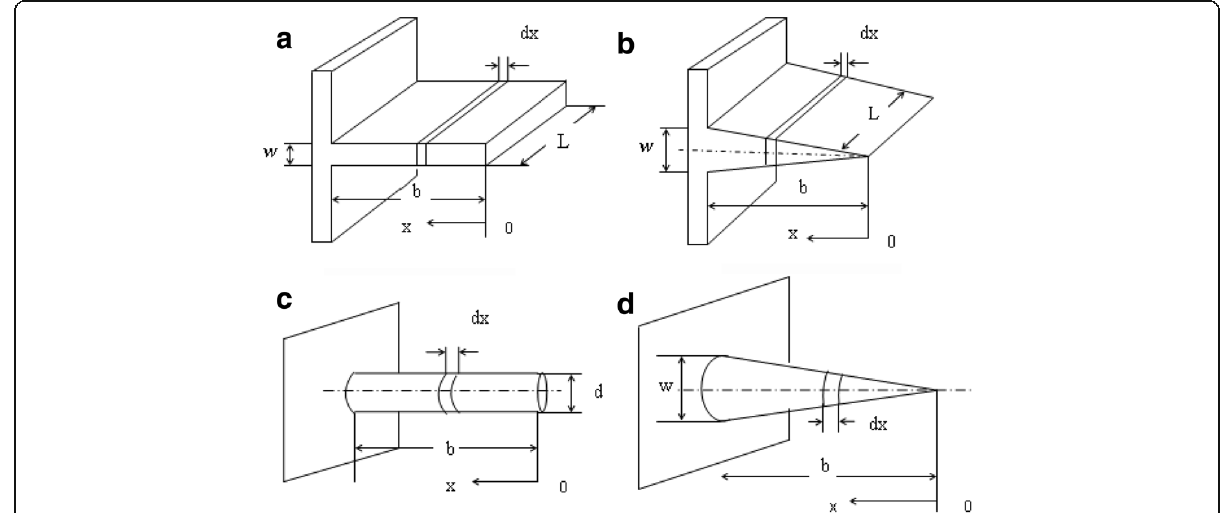
Fig. 1 Sketch diagram of longitudinal fins of rectangular ( a ) and triangular profile ( b ) and pins of cylindrical ( c ) and conical profile ( d )